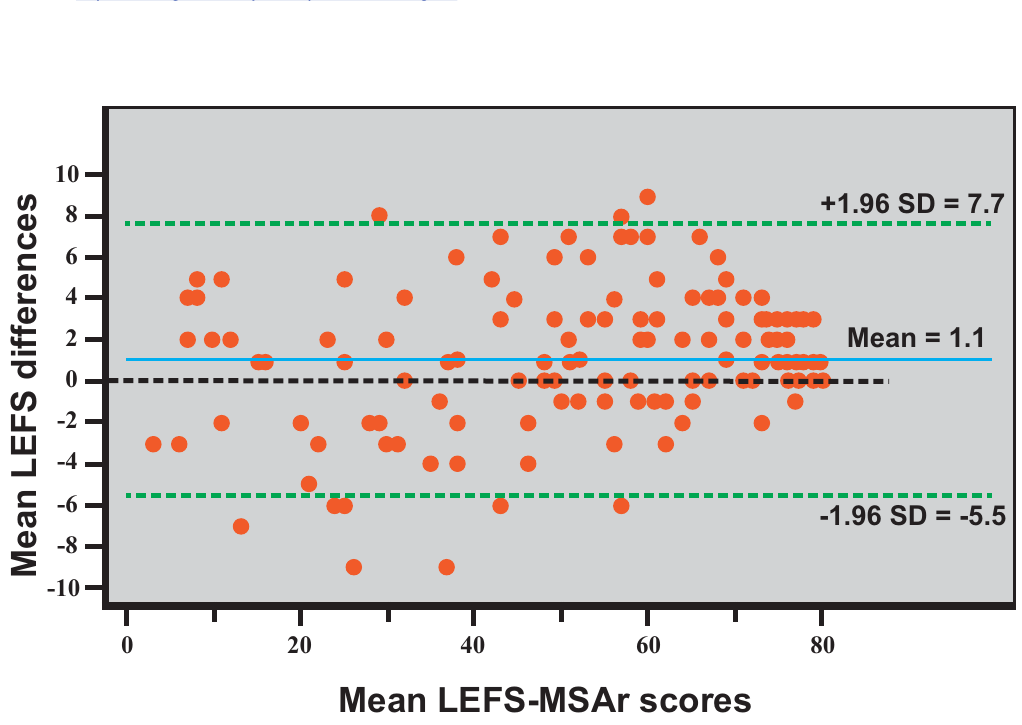
Fig 4. Bland-Altman plot. A Bland-Altman plot visualizing the agreement for test-retest, with the limits marked as maen ± SD difference. Means and differences were calculated using total original scores of the scale. Abbreviations: LEFS-MSAr, lower extremity functional scale modern standard Arabic